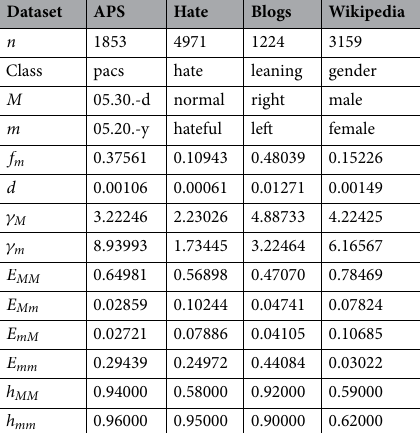
Table 3. Empirical Networks. APS, a scientific citation network. Hate, a retweet network. Blogs, a political blog hyper-link network. Wikipedia, a hyper-link network of politicians. Each row represents a property of the network. E ∗∗ represents the fraction of edges within and across groups, and h ∗∗ homophily values inferred by the DPAH model (see Supplementary Appendix A for